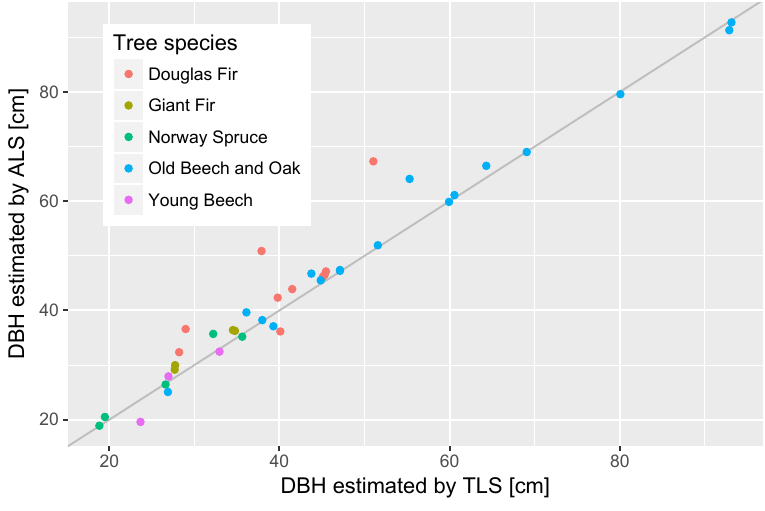
Figure 9. DBH of TLS compared to ALS. Grey line is